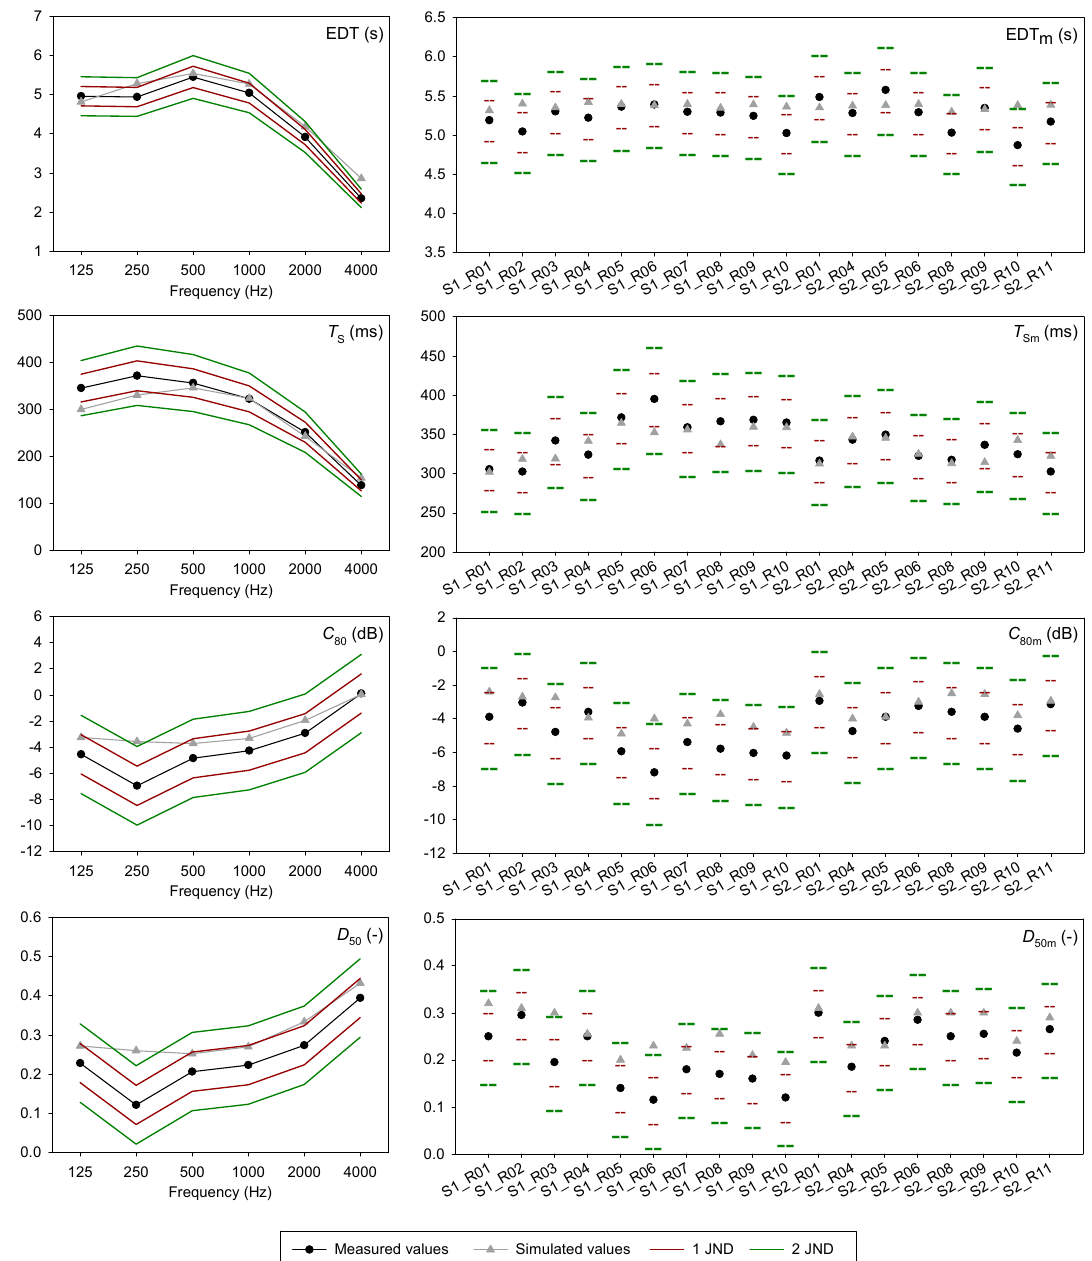
Figure 6. Measured and simulated values of several acoustic parameters (from top to bottom: EDT, T S , C 80 , and D 50 ): Spectral behaviour of the spatially averaged values (left column) and spectrally averaged values obtained at each source-receiver combination (right column). The values corresponding to 1 and 2 JND have been also included.